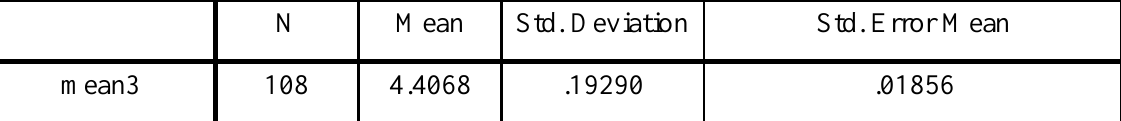
Figure 16. Descriptive statistics of the variable in sub-hypothesis C